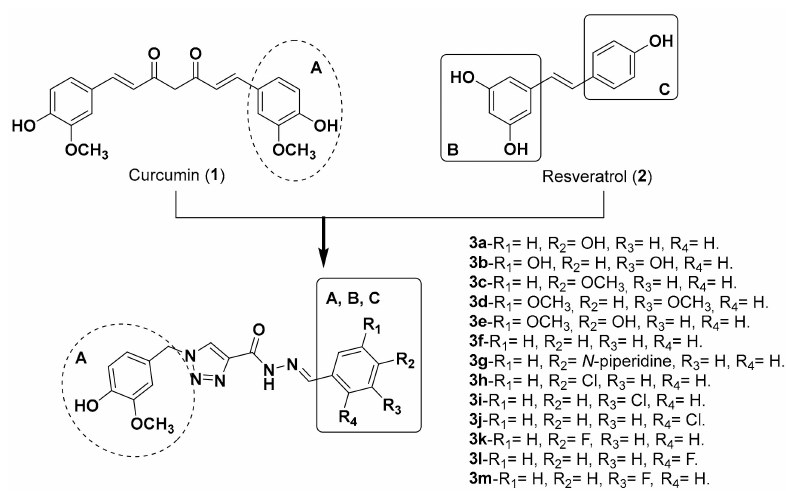
Figure 1. Planning by molecular hybridization of the molecular family synthesized in this work.